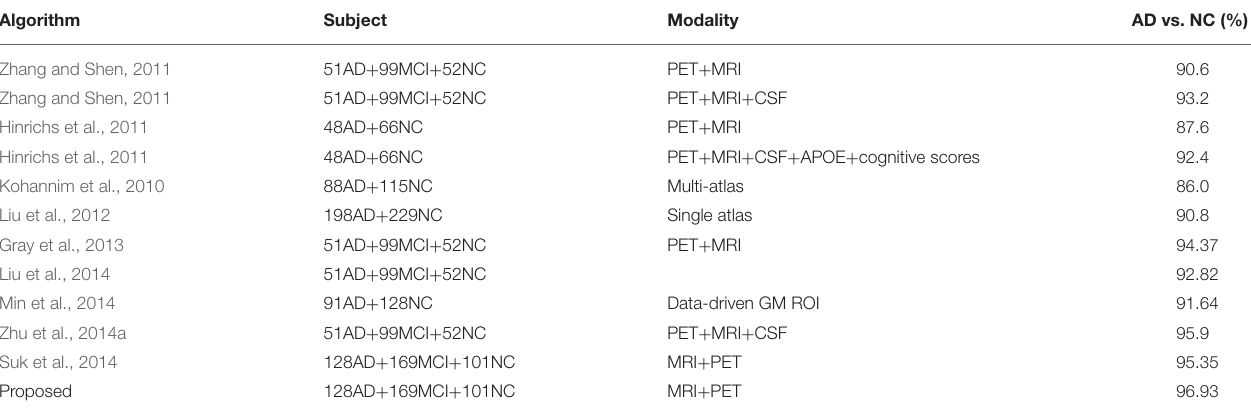
TABLE 3 | Algorithm comparison for AD vs. NC classification results.